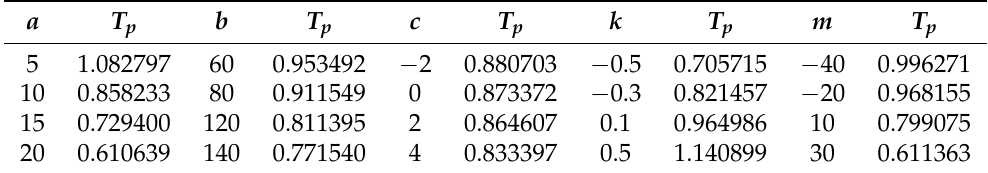
Table 3. Periods T p of cycle 2 for different